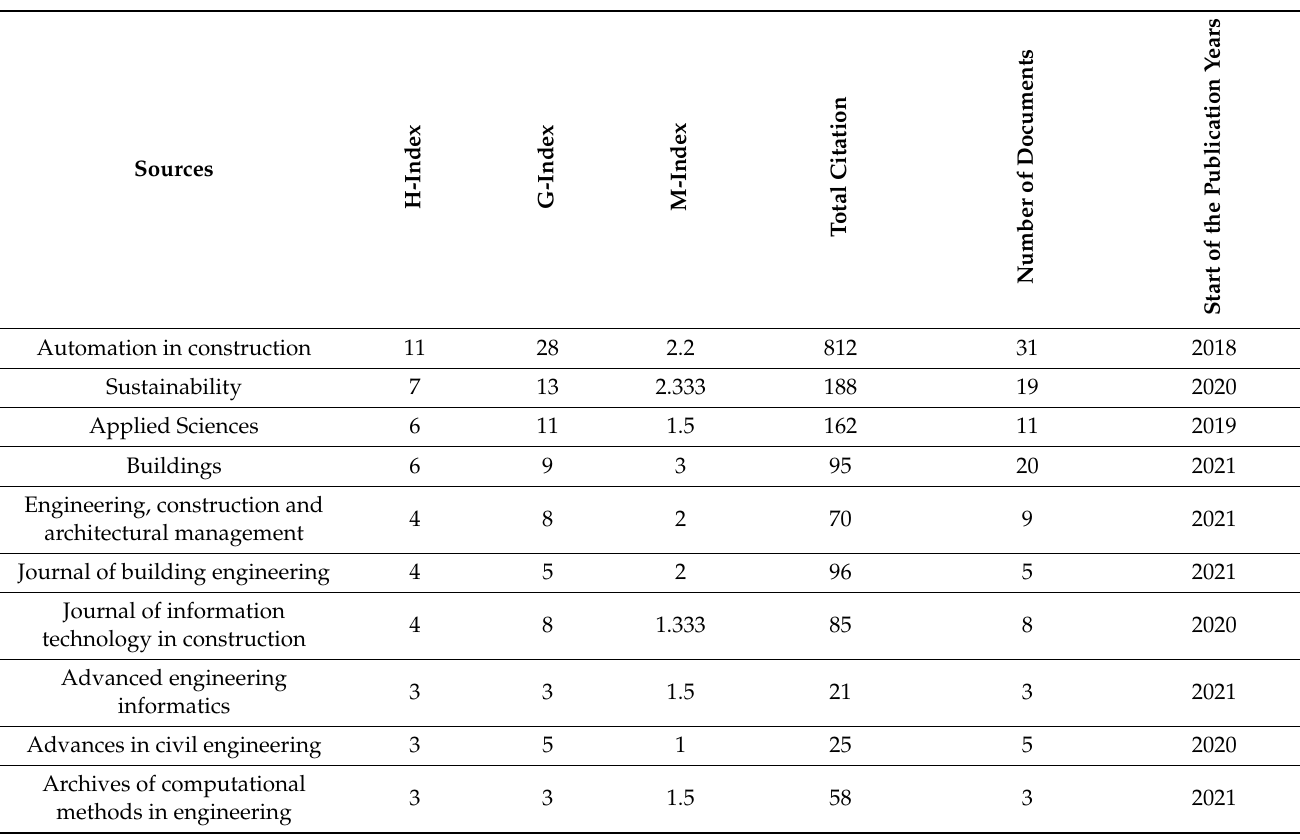
Table 9. Sources’ impact analysis, performed with Biblioshiny version 4.0.